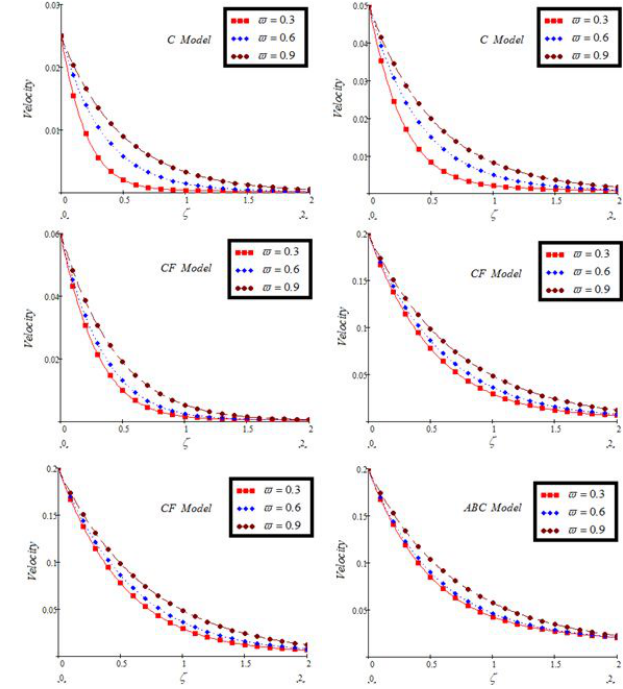
Figure 5: Velocity profile for FD’s with variation of G r and Pr = 0.7, M = 2, ε = 0.4